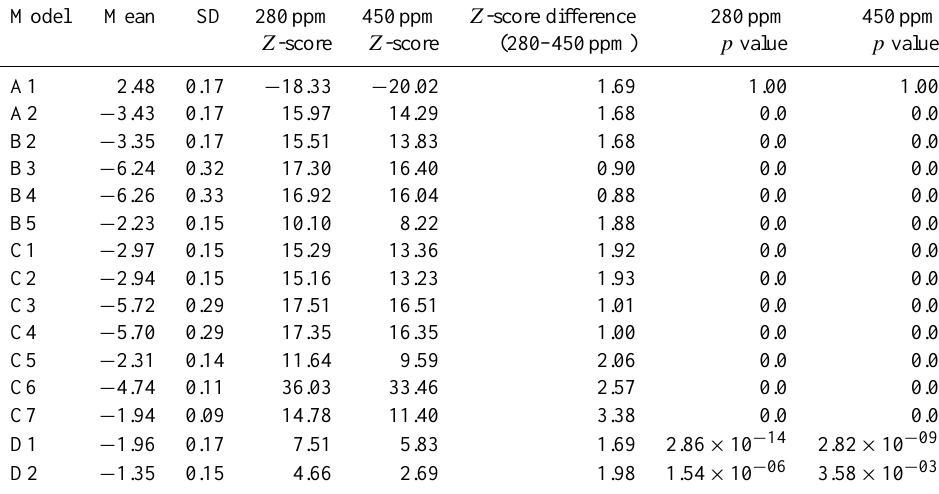
Table E2. Mean value and standard deviation (SD) of chance agreement estimated from a selection of models, with 5000 full comparisons of data and models at all 167 fossil sites used in the analysis. Also shown are the Z -scores for the 280 and 450ppm vegetation reconstructions and the difference between them, and the p values calculated from these Z -scores. A value of 0.0 in the p value column implies p <10 − 15 or